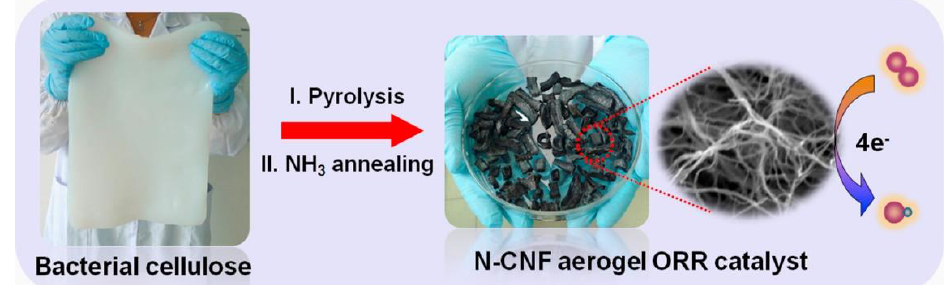
Figure 19. Optical pictures (left and middle) and SEM image (right) showing the procedures for making a nitrogen doped carbon nanofiber aerogel as a metal-free catalyst for oxygen reduction reaction catalysis in zinc-air battery. Reprinted with permission from [136]. Copyright © 2014 Elsevier